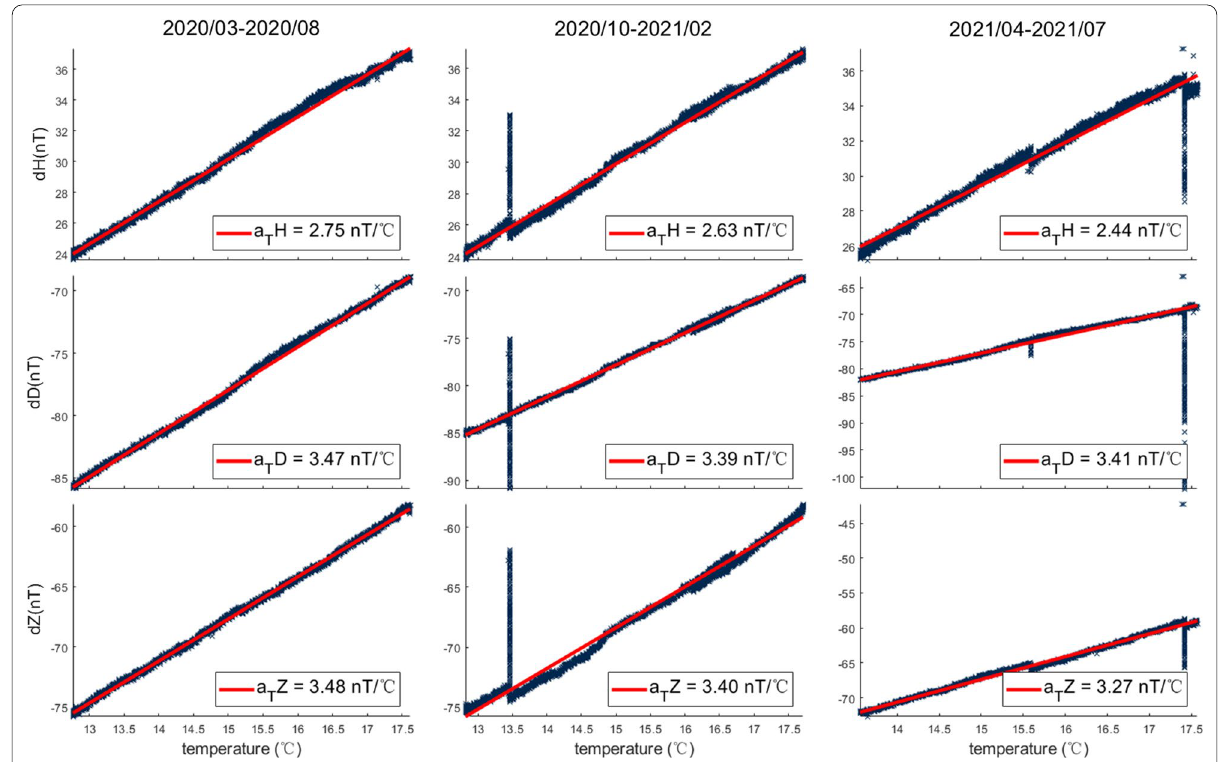
Fig. 9 Linear regression of the relative temperature coefficients before and after the temperature inflection